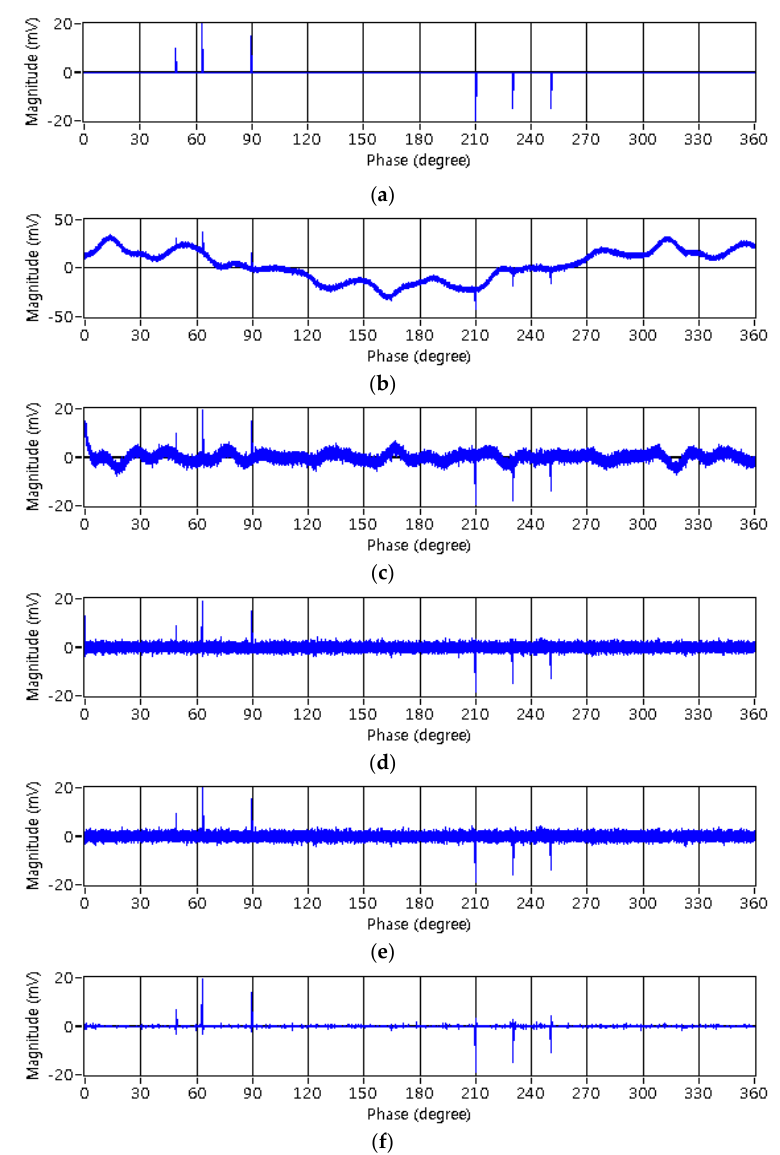
Figure 10. Disturbance elimination for simulated PRPD signal. ( a ) Simulated PD pulse sequences; ( b ) simulated PRPD; ( c ) with a 1 kHz filter; ( d ) with a 100 kHz filter; ( e ) via noisy D1–D5; ( f ) via de-noised D1–D5.